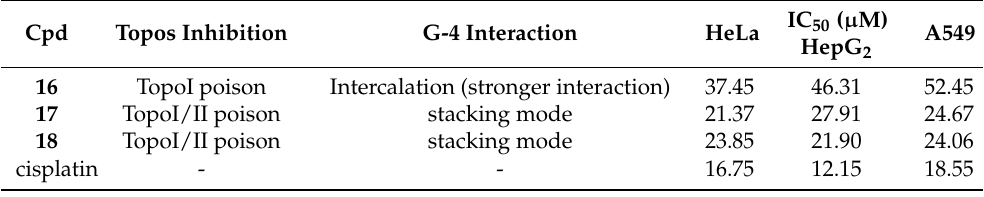
Table 4. Summary of the biological activities of ruthenium(II) polypyridyl complexes 16 – 18 and